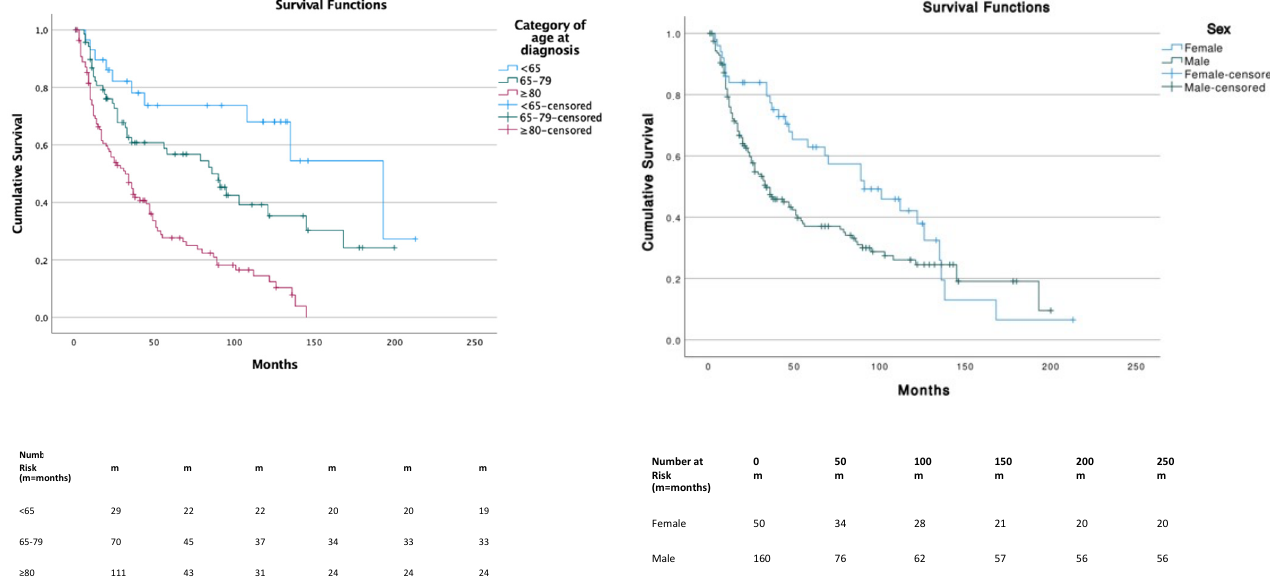
Figure 2. Survival distribution according to age and gender . Patients with tumor sizes ≤ 5 cm corresponding to T1 ( ≤ 2 cm) and T2 (2–5 cm) had a significantly ( p < 0.001) higher OS compared to T4 (i.e., primary tumor invades fascia, muscle, cartilage or bone). No significant differences were found across different N stages. The presence of metastasis (M1) was associated with a significantly ( p < 0.001) lower sur- vival (median, 7 months; 95% CI, 3.1–10.9) compared to M0 (median, 52 months; 95% CI, 26.3–77.7) (Figure 3).